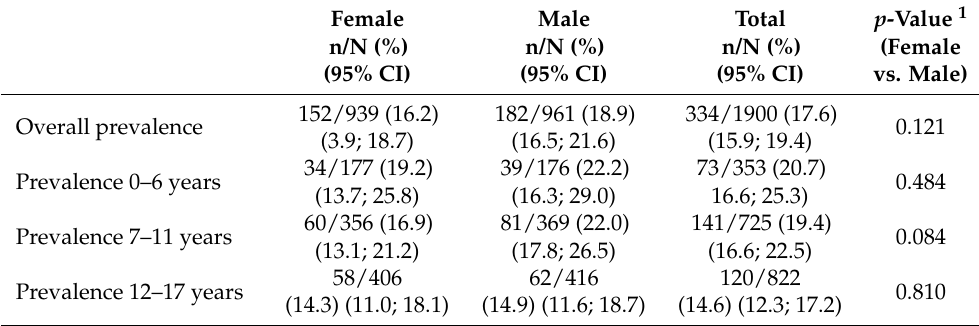
Table 2. Prevalence of sleep bruxism (SB) with 95% confidence interval (CI): overall, by sex, and by age. N, total number of subjects in the category; n, number of subjects with SB in the